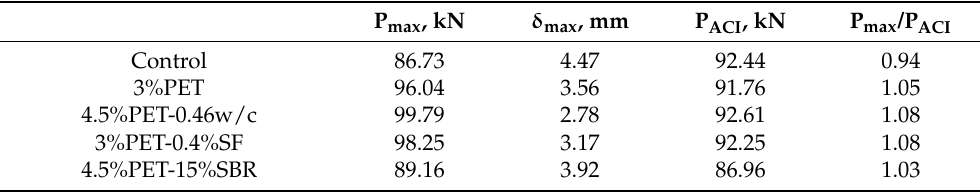
Table 3. Flexural strength properties of investigated RC